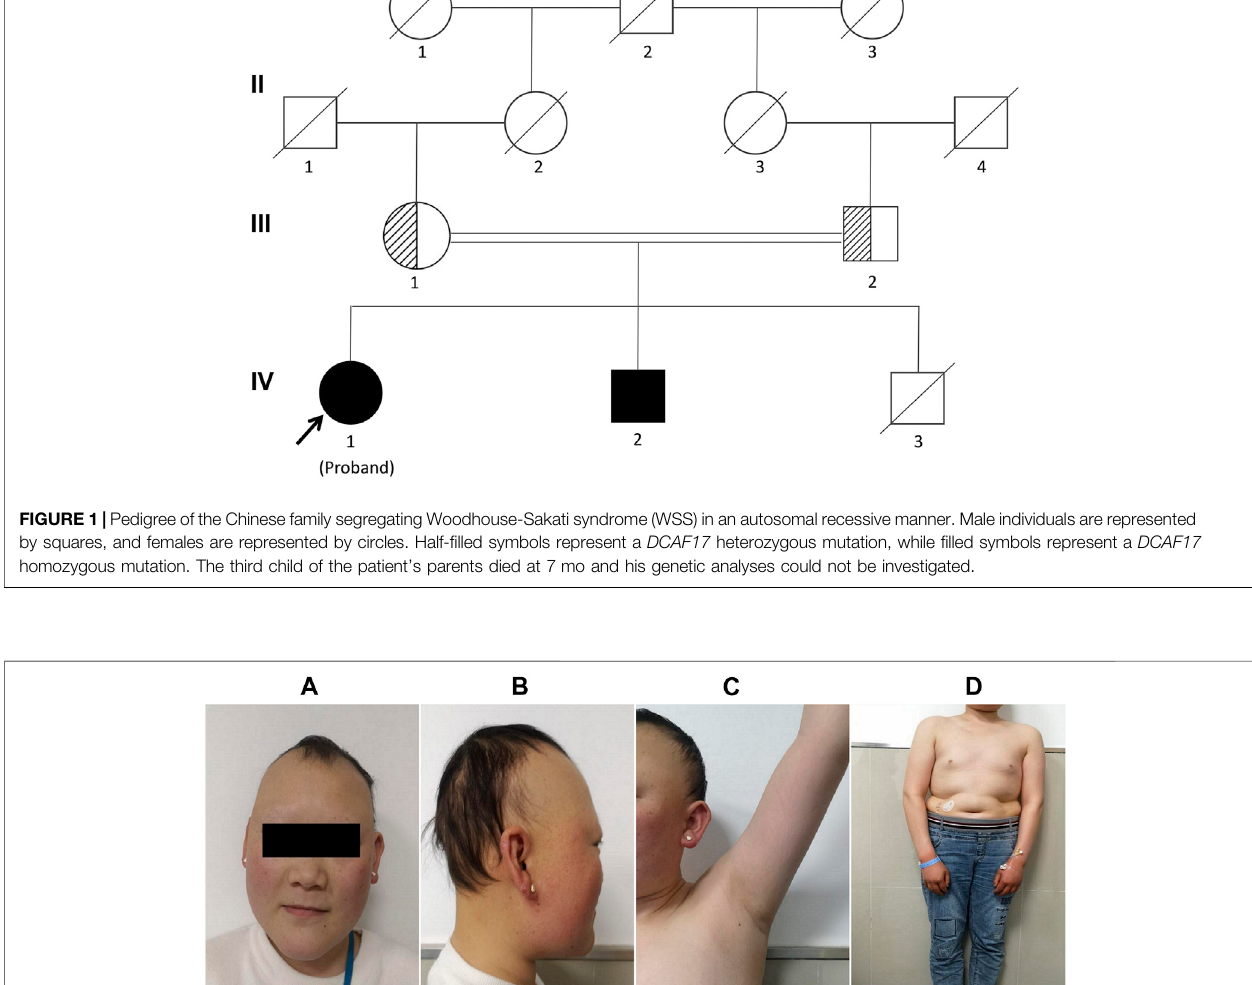
Frontiers in Genetics |